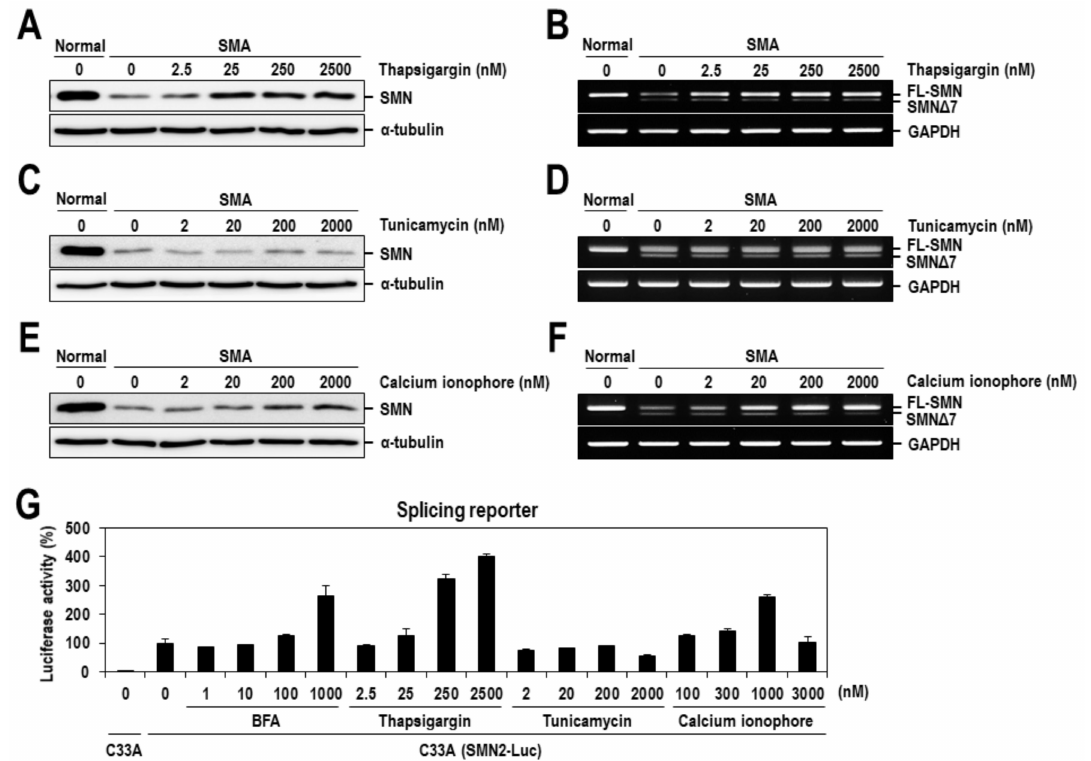
Figure 3. SMN2 exon 7 splicing is affected by calcium-modulatory chemicals. SMA fibroblasts were dose-dependently treated with thapsigargin ( A ), tunicamycin ( C ) or calcium ionophore ( E ) for 24 h and cell lysates were prepared and the expression of SMN protein was analyzed by Western blotting with anti-SMN antibody. The α -tubulin was also analyzed as a loading control. ( B , D , F ) Total RNAs were prepared from the cells used in panel ( A , C , E ) and subjected to RT-PCR analysis for SMN2 exon 7 inclusion/exclusion. PCR products run on an agarose gel are presented. ( G ) SMN2-Luc cells (C33A) were treated with various concentrations of BFA, thapsigargin, tunicamycin or calcium ionophore for 24 h, and then assayed for the firefly luciferase activity. Luciferase activities were normalized to that from C33A(SMN2-Luc) cells treated with DMSO. The mean values and standard deviation were determined from three independent